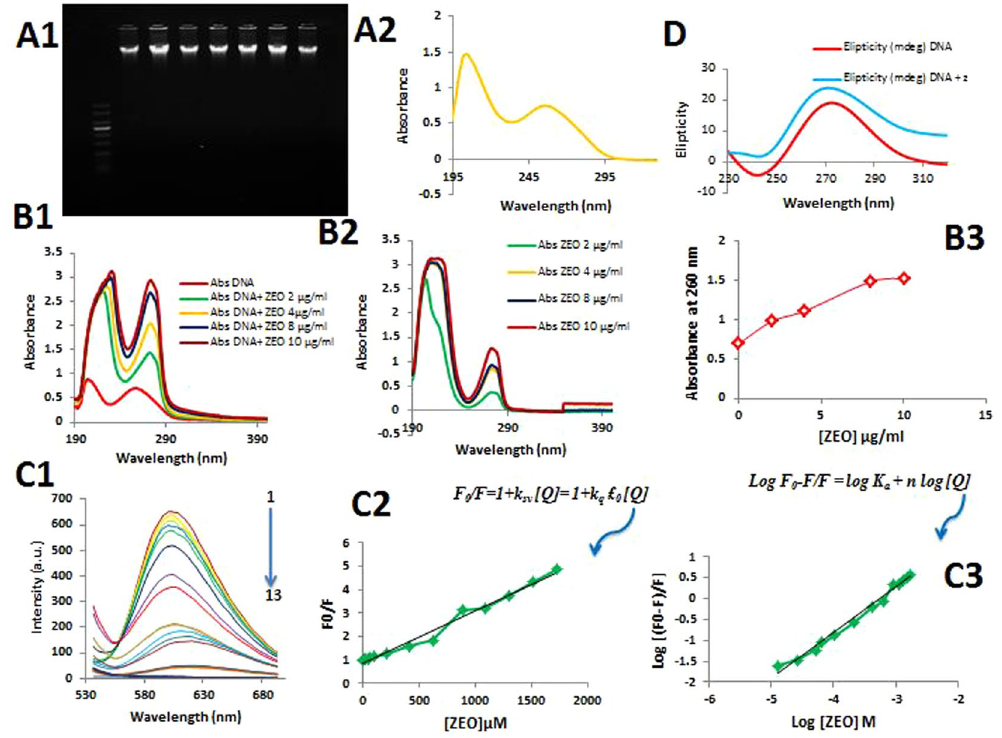
Figure 8. ( A1 , A2 ) High molecular weight DNA on 0.8% agarose gel after 40 min electrophoresis at 5 v/cm and UV–Visible spectra of rat hepatocyte genomic DNA. ( B1 , 2 , 3 ) UV absorption spectra of a: 0–32 μ g/ml of ZEO, b: DNA with various concentrations Of ZEO c: DNA/ZEO absorption at 260 nm ( C1 ) Fluorescence quenching spectra of EB–DNA solutions (C EB = 2.6 μ M, C DNA = 50 μ g/ml) upon addition of increasing amounts of ZEO (2–224 μ g/ml) (pH = 7.4, T = 310 K, ex = 500 nm, em = 530–700 nm). ( C2 , C3 ) Stern–Volmer plots for